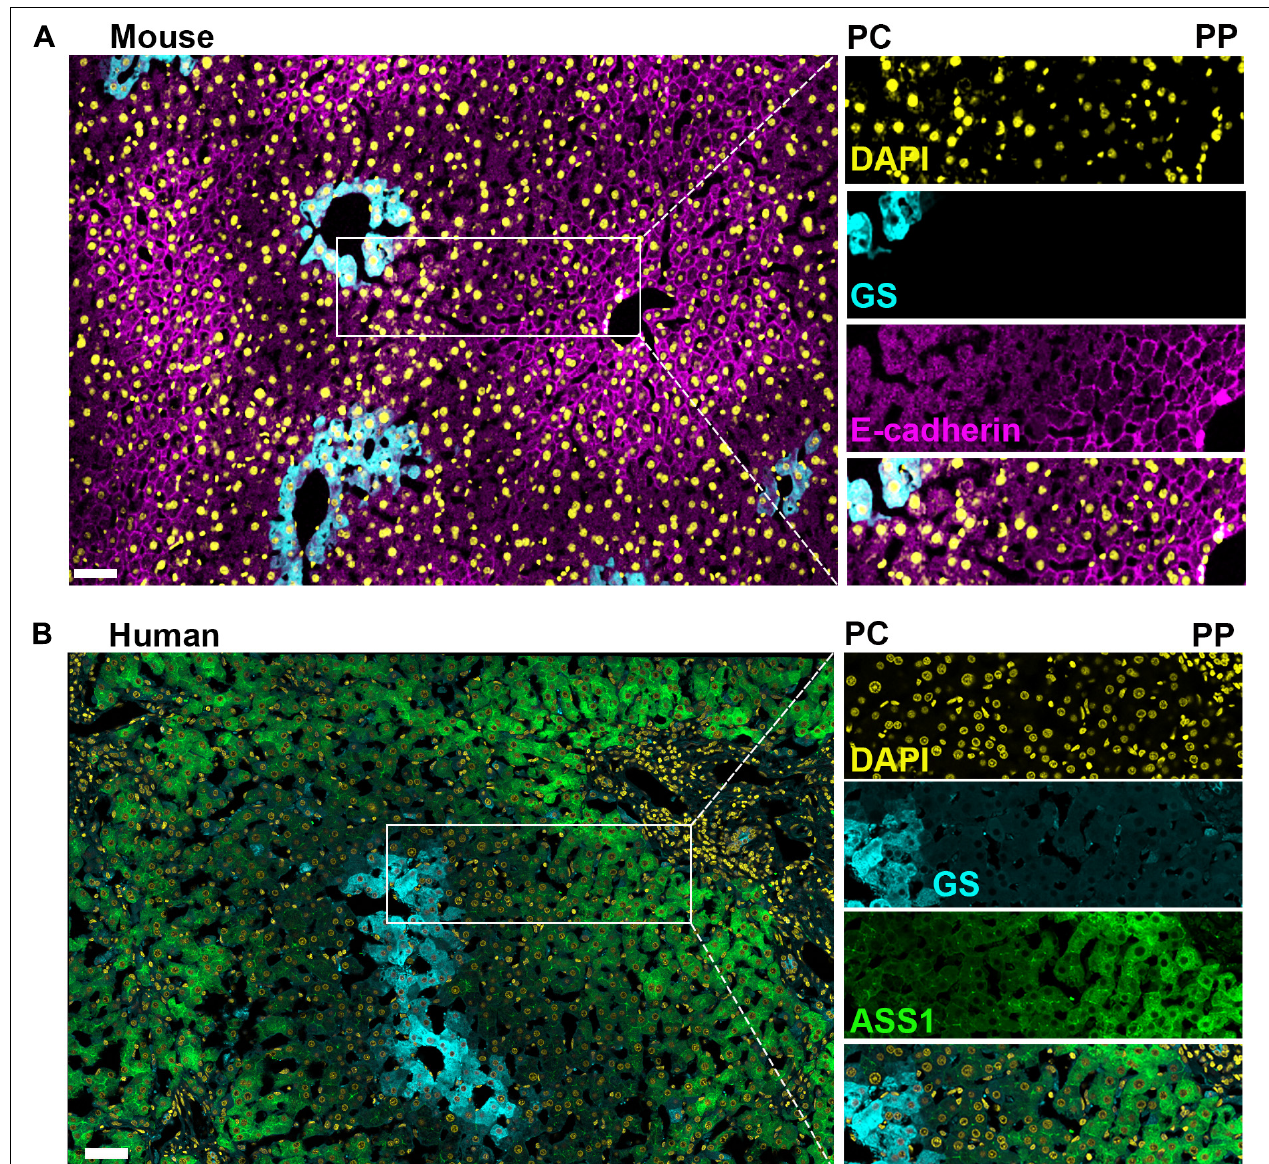
FIGURE 3 | Comparison of mouse and human liver lobules. Confocal microscopy image of immunofluorescence-stained mouse and human liver sections illustrate the conservation and differences between species regarding markers of hepatocyte heterogeneity. (A) Mouse liver section with a pericentral (PC) to periportal (PP) axis highlighted showing; a uniform nuclei distribution across the axis (DAPI in yellow), glutamine synthetase (GS) is selectively expressed in pericentral hepatocytes (cyan), and E-cadherin is enriched in periportal hepatocytes (magenta). (B) Human liver section with a pericentral (PC) to periportal (PP) axis highlighted showing; a uniform nuclei distribution across the axis (DAPI in yellow) and glutamine synthetase selectively expressed in pericentral hepatocytes (cyan), while argininosuccinate synthase 1 (ASS1, green) is expressed predominantly in periportal hepatocytes. Pericentral expression of glutamine synthetase is conserved between murine and human. Scale bar = 50 µ